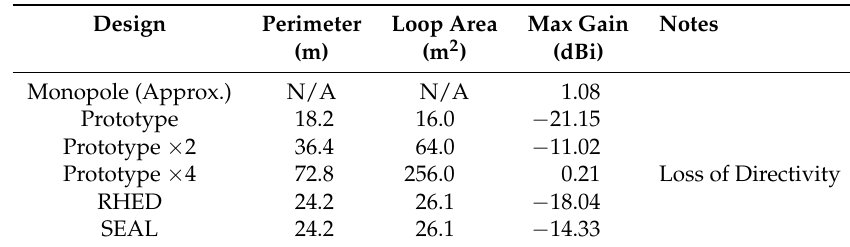
Comparison of numerical simulation results for the simplified SeaSonde antenna and alternate layouts for the directive antenna. Monopole refers to the SeaSonde transmitter; Prototype refers to the preliminary test, and Prototype × 2, Prototype × 4 refer to the prototype scaled twice or four-times. RHED and SEAL refer to the approximate layouts as currently deployed at those field sites. See (Figure